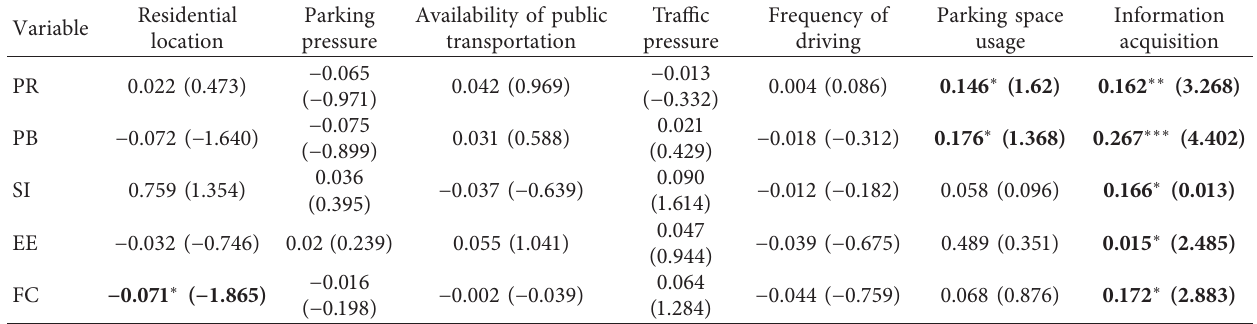
Table 9: Influence of exogenous factors on latent